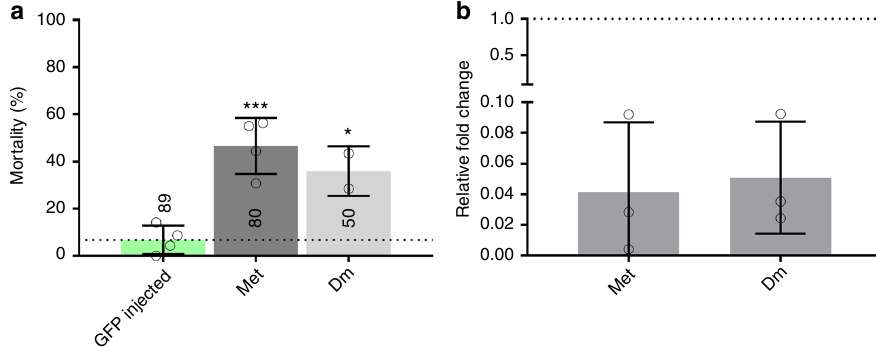
Fig. 4 RNAi phenotyping for potential transcription factor candidates. RNAi was performed using the pyrethroid resistant Tiassalé colony. Three to fi ve- day-old females mosquitoes were injected with dsRNA from each of the respective transcripts. Seventy two-hours post injection, the mosquitoes were exposed to 0.05% WHO deltamethrin papers for 1 h and mortality scored 24 h later. a Deltamethrin induced mortality following dsRNA induced knockdown of the transcription factors Met and Dm. b Knockdown levels for each dsRNA construct relative to GFP-injected controls. Error bars represent standard deviation, three biological replicates and three associated technical replicates were used for each gene in the qPCR data and signi fi cance is indicated by * p ≤ 0.05, ** p ≤ 0.01, *** p ≤ 0.001, as computed by ANOVA with post hoc Tukey correction. Numbers on the bars represent number